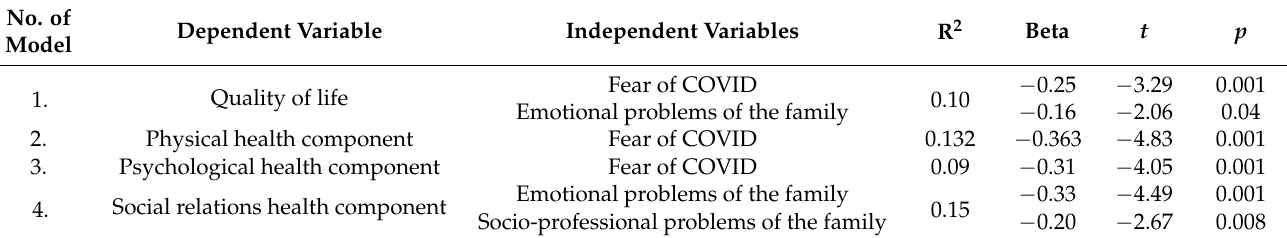
Table 8. The predictors of the regression